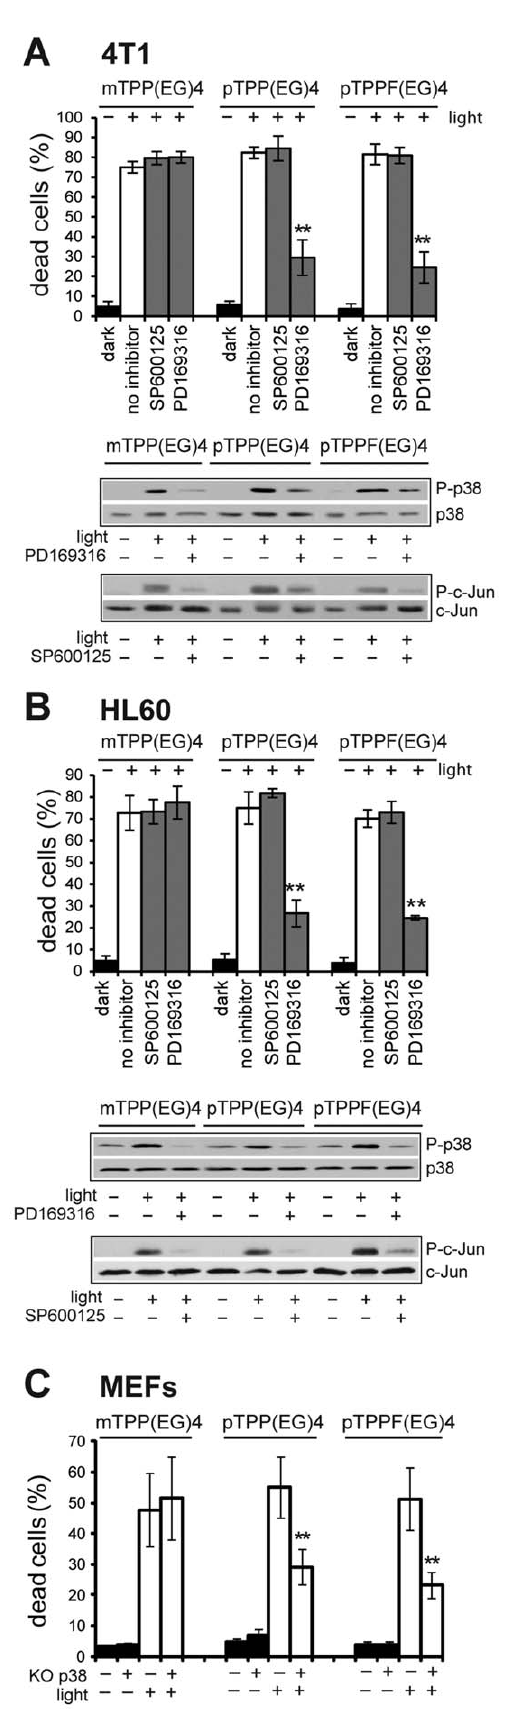
Figure 2. Effect of kinase inhibitors on EG-porphyrin-mediated phototoxicity in 4T1 and HL60 cells. 4T1 cells ( A ) or HL60 cells ( B ) were loaded with EG-porphyrin derivatives for 16 h, washed and then preincubated for 1 h JNKII inhibitor (5 m M) and PD169316 (10–20 m M) before light exposure. After irradiation the cells were further cultivated and cell viability was determined 24 h post-PDT by the trypan blue exclusion method. Cells treated with EG-porphyrin derivatives without irradiation were used as controls (dark). The percentage of dead cells was expressed as the mean 6 SD (n=4). ** P , 0.01 represents statistical differences between PDT-treated cells vs. PDT-treated cells in the presence of JNKII or PD169316. For Western blot analysis cells were pre- incubated for 1 h with JNKII inhibitor (SP600125) or p38 inhibitor (PD169316) and 2 h post-irradiation analyzed with specific antibodies recognizing the phosphorylated forms of p38 and c-Jun by Western blot (P-p38 and P-c-Jun, respectively). Equal loading is demonstrated by total c-Jun and p38 protein. ( C ) Effect of p38 deletion on apoptotic cell death. Mouse embryo fibroblasts (MEFs) with intact (wt) and inactivated p38 a 2 / 2 (KO) gene were exposed to EG-porphyrin-mediated PDT. Cell viability was evaluated 24 h post-PDT by the trypan blue exclusion method. **P , 0.01 represents statistical differences between wt MEF vs. KO MEF exposed to